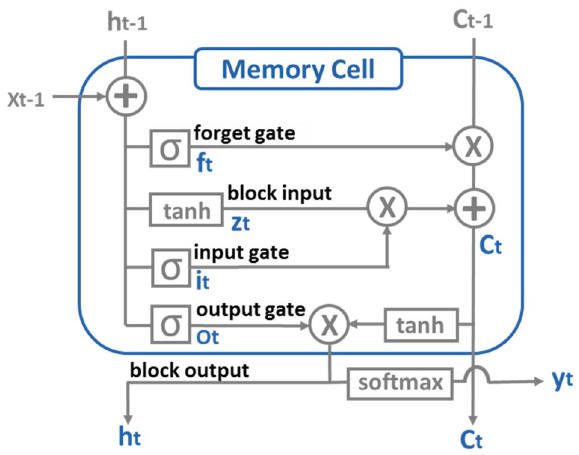
Figure 12. Illustration of LSTM architecture. LSTM is consisted of block input, input gate, forget gate, output gate, block output, and memory cell. Computed one hot vector is outputted through the softmax